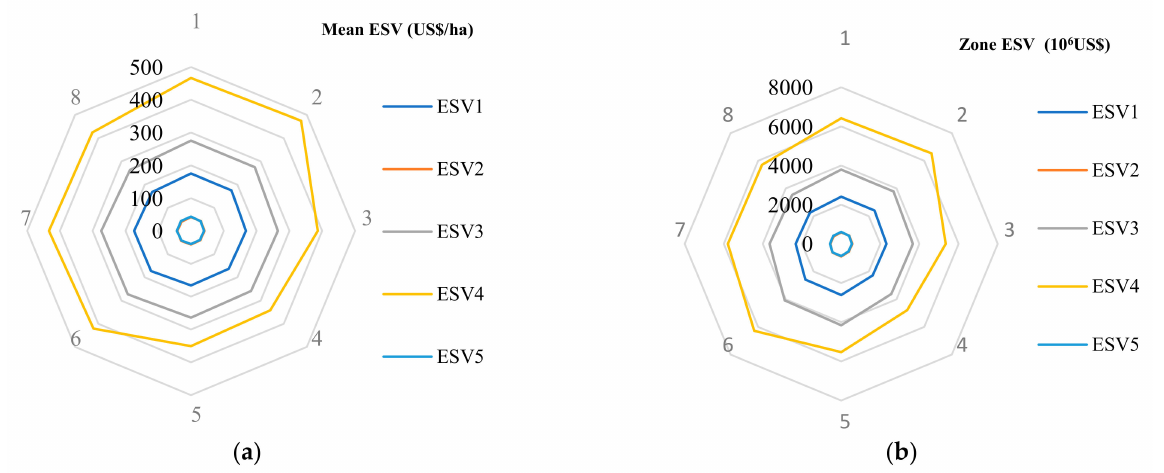
Figure 7. Five ESVs of grassland ecosystem in the different aspect zones. ( a ) the variation of five mean ESVs in different aspect zones. ( b ) the variation of five zone ESVs in different aspect zones. The aspect range of zone 1~8: <45 ◦ , 45 ◦ ~90 ◦ , 90 ◦ ~135 ◦ , 135 ◦ ~180 ◦ , 180 ◦ ~225 ◦ , 225 ◦ ~270 ◦ , 270 ◦ ~315 ◦ , and ≥ 315 ◦